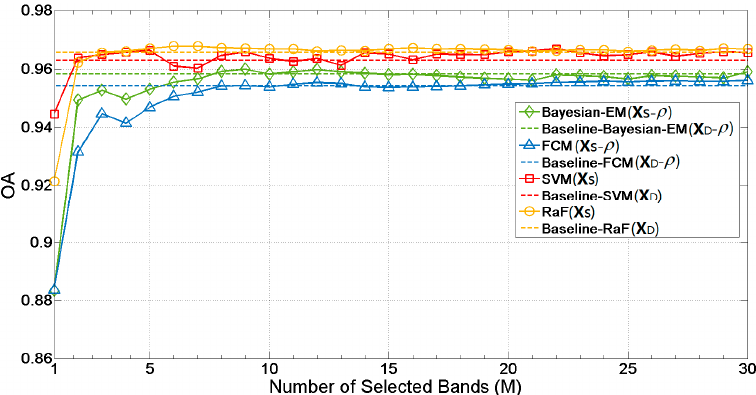
Figure 9. Binary CD accuracies obtained by the proposed CD approaches based on BS-DR (Yancheng dataset). The unsupervised Bayesian-EM and FCM were applied on the compressed magnitude of X S (i.e., X S - ρ ) and the supervised SVM-based and RaF-based approaches were applied on the uncompressed X S . Baseline results (on X D ) are shown as dashed lines for comparison purposes.